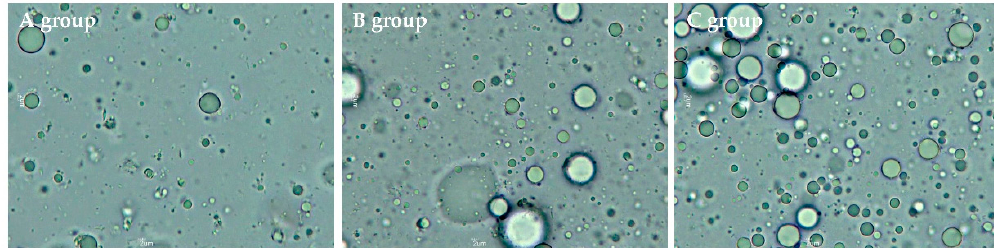
Figure 3. The optical microscopic images of human milk samples in different groups.